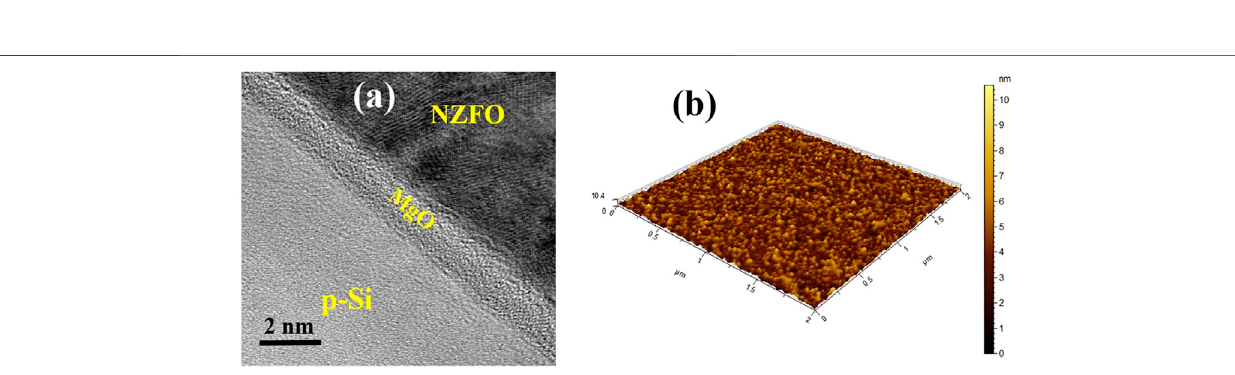
Frontiers in Materials |